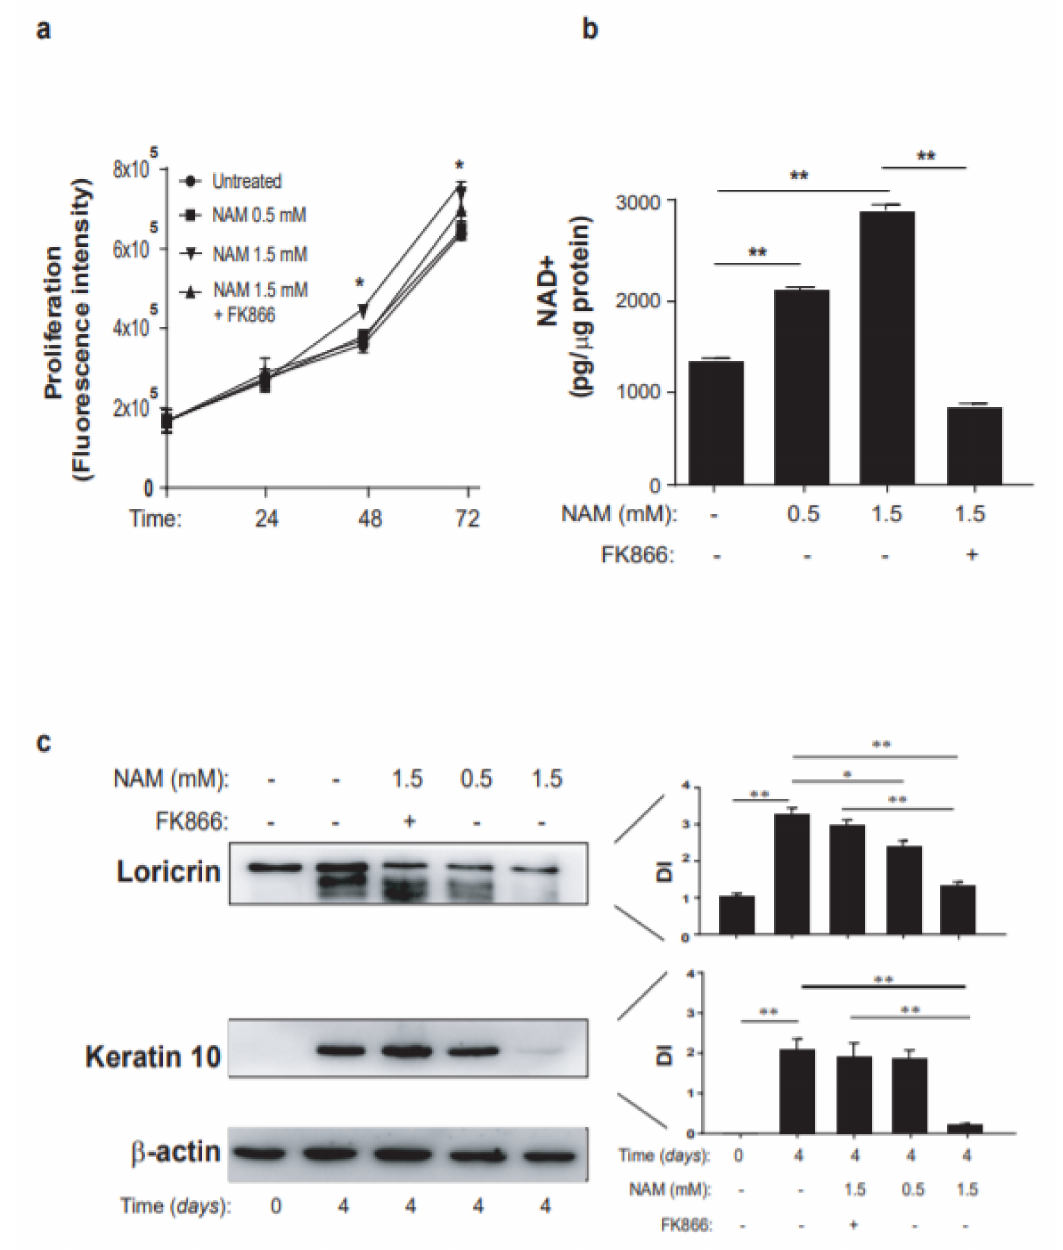
Figure 3. NAM induces proliferation and prevents differentiation of human primary keratinocytes. ( a ) Cell proliferation was evaluated by CyQUANT assay performed on keratinocyte cultures growth in KBM and left untreated or treated with increasing doses of NAM (0.5–1.5 mM), in presence or not of FK866 (0.1 µ M) for 24, 48, and 72 h. Data are shown as the mean of fluorescence intensity values obtained from three independent experiments carried out on n = 3 different strains ± SD. * p ≤ 0.05 by paired Student’s t test. ( b ) Keratinocyte cultures were treated with increasing doses of NAM (0.5–1.5 mM) in KBM for 24 h or left untreated. NAD + levels were quantified by colorimetric assay and expressed as mean of pg/ µ g of total proteins. Data are expressed as mean of three independent experiments ± SD. ** p ≤ 0.01 by paired Student’s t test. ( c ) Keratinocyte cultures were subjected to culture conditions determining terminal differentiation. The latter was achieved by growing cells at 100% of confluence (t0) and, thus, keeping them in culture for another 4 days in presence or absence of increasing NAM doses. Where indicated, cells were exposed treated with FK866 (0.1 µ M) together with NAM. Loricrin and keratin 10 protein levels were analyzed by WB. DI indicates the densitometric intensity of the indicated proteins normalized for β -actin shown in one representative of three different WB. Data are represented as mean ± SD. * p ≤ 0.05 and ** p ≤ 0.01 assessed by paired Student’s t